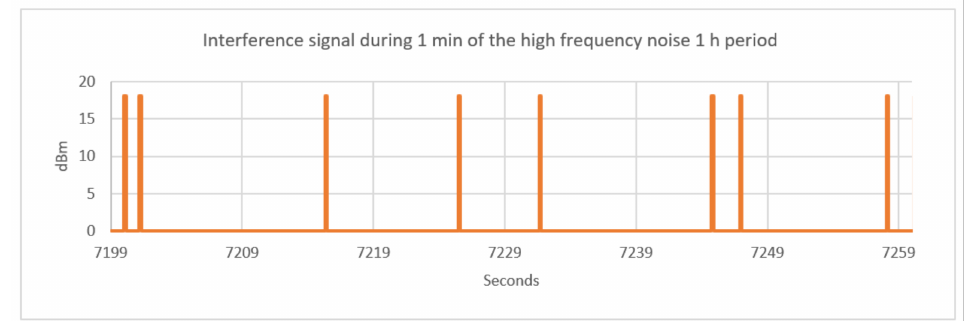
Figure 7. View of the signal during one minute of one of the 1 h high frequency interference